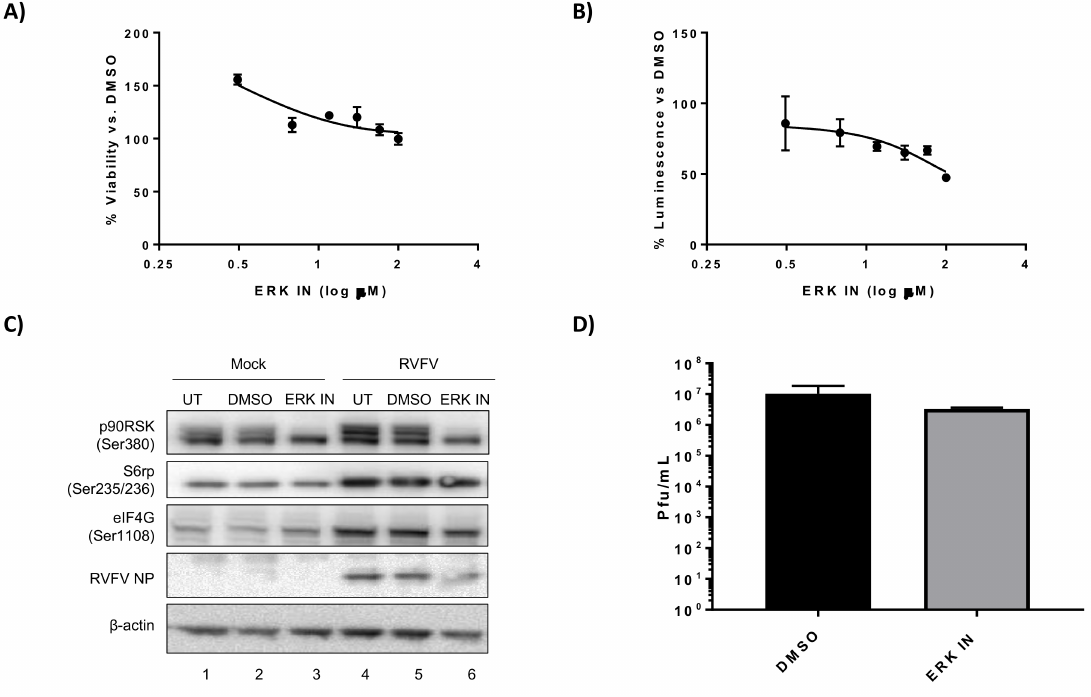
Figure 5. PD0325901, an ERK inhibitor, has a minimal effect on RVFV replication. ( A ) H2.35 cells